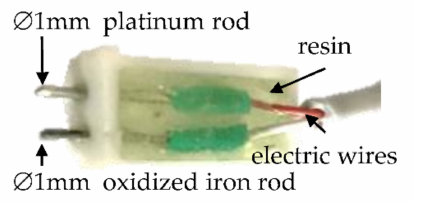
Figure 1. Design of the oxidation–reduction potential (ORP)